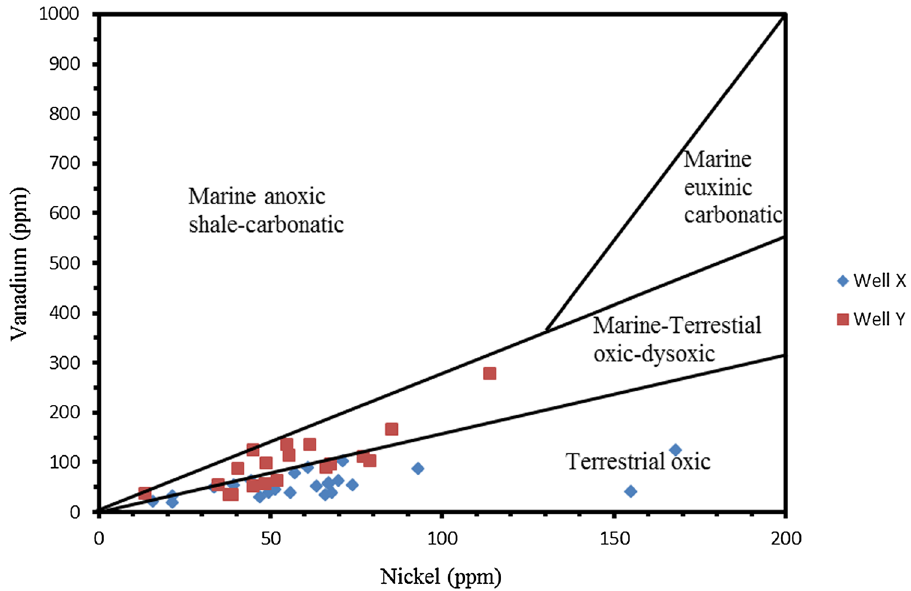
Fig. 8 Cross-plot of vanadium versus nickel showing that kerogens from the central Niger Delta have terrestrial and mixed marine/terrestrial source inputs and were deposited under vary- ing oxic to dysoxic conditions (Modified after Galarraga et al.